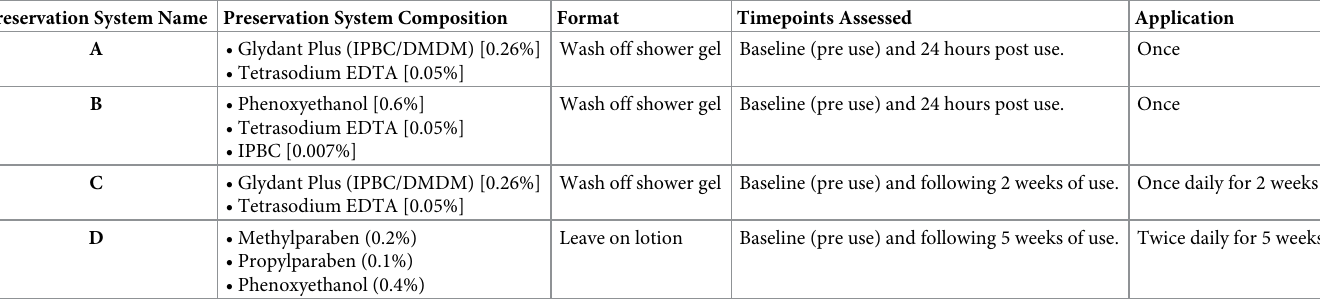
Table 1. Summary information on the different preservation systems, product formats, and product application regime used in the subsequent analysis. Preservation System Name Preservation System Composition